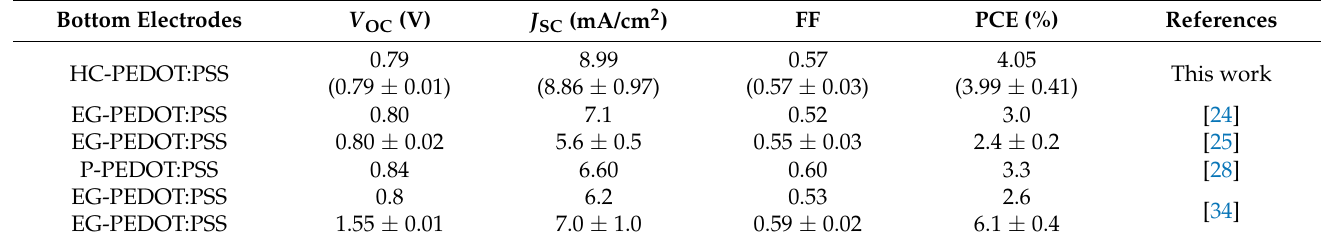
Table 2. PCE statistics of single-junction all plastic solar cells, reported before and this work.